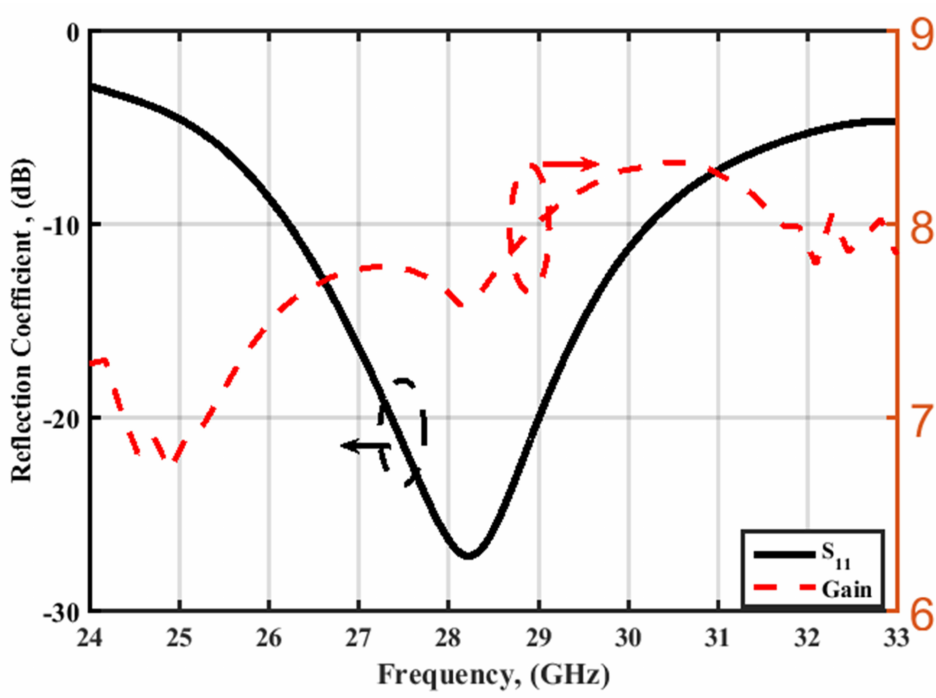
Figure 5. Reflection coefficient and gain characteristics of the 1 × 2